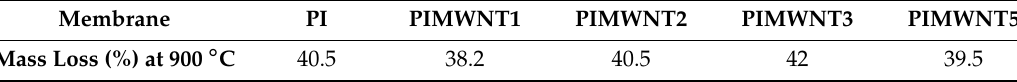
Table 2. Loss of membrane mass during pyrolysis at the maximum temperature and glass transition temperature of the polymer.